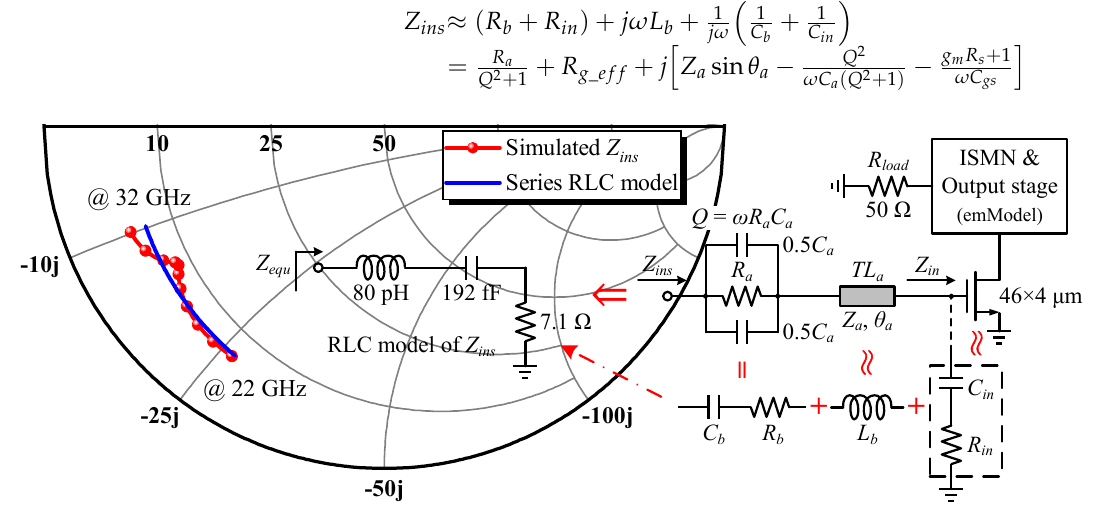
Figure 13. Input impedance characteristics of the stabilized 46 × 4 μ m cell and the series RLC equivalent circuit.